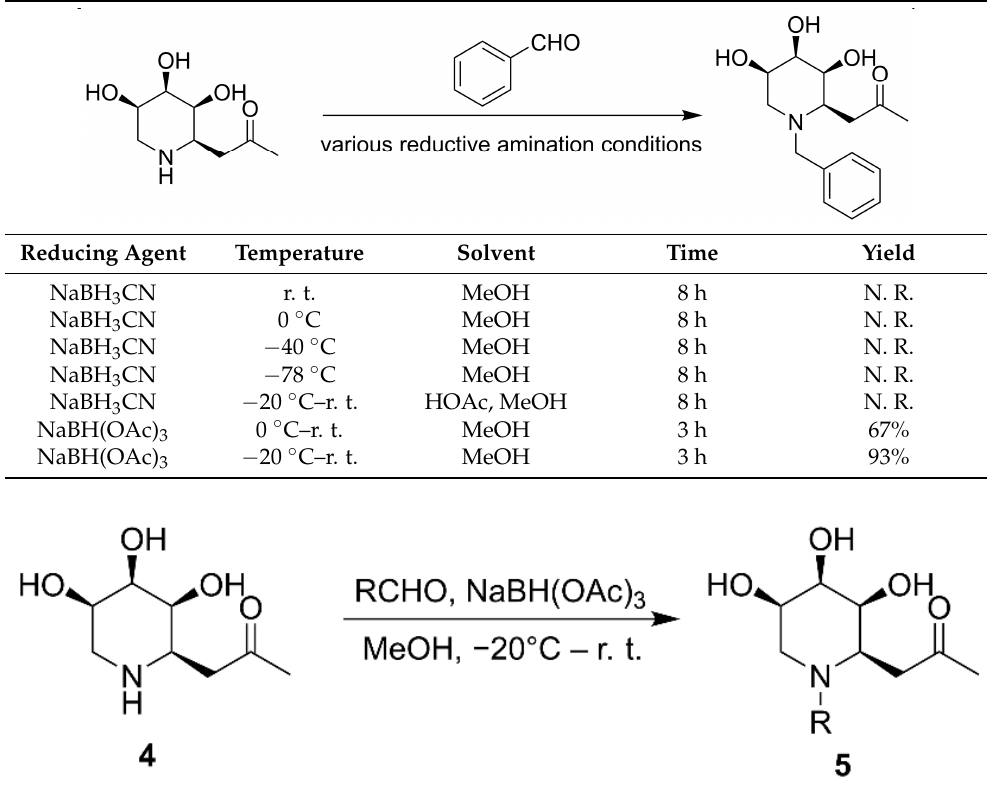
Table 1. Screening of synthesis conditions of N -substituted iminosugar C -glycosides.